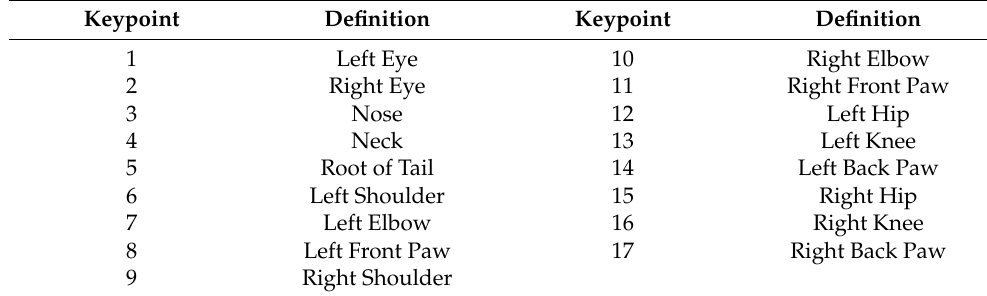
Table 1. Definitions of animal keypoints.